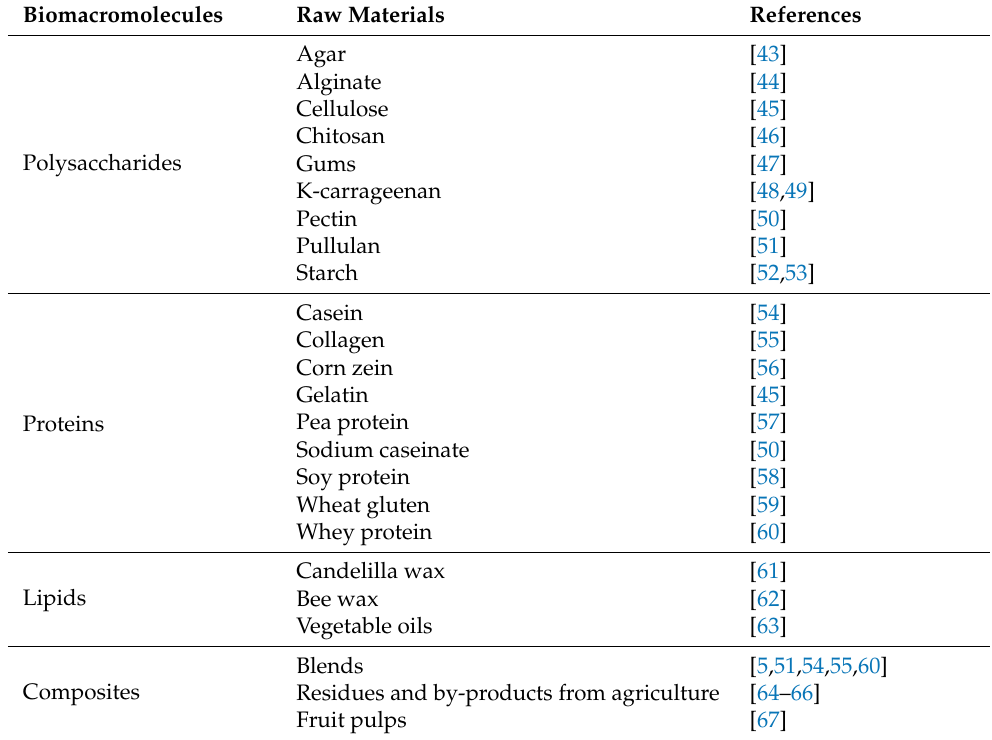
Table 1. Natural materials used in edible films and coatings.